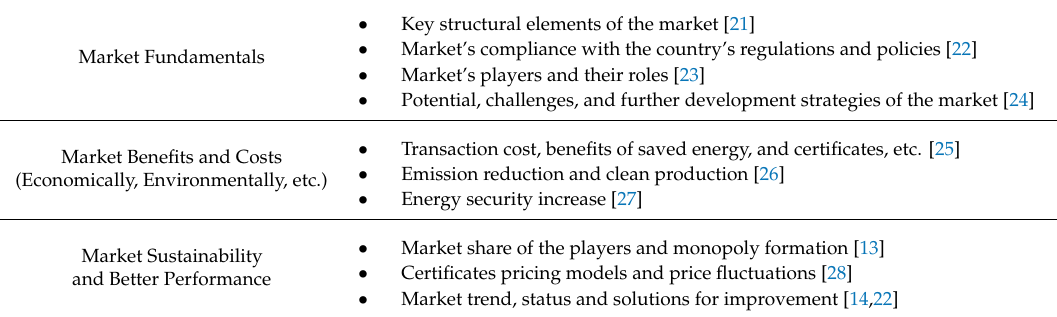
Table 1. Main categories of studies about ESC market (source: categorized by authors).